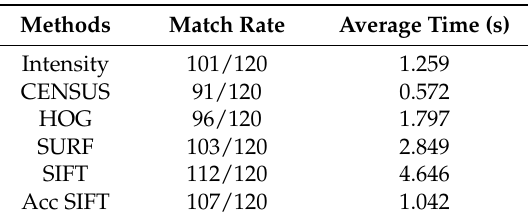
Table 3. Comparison of the different descriptors on the Kashiwa